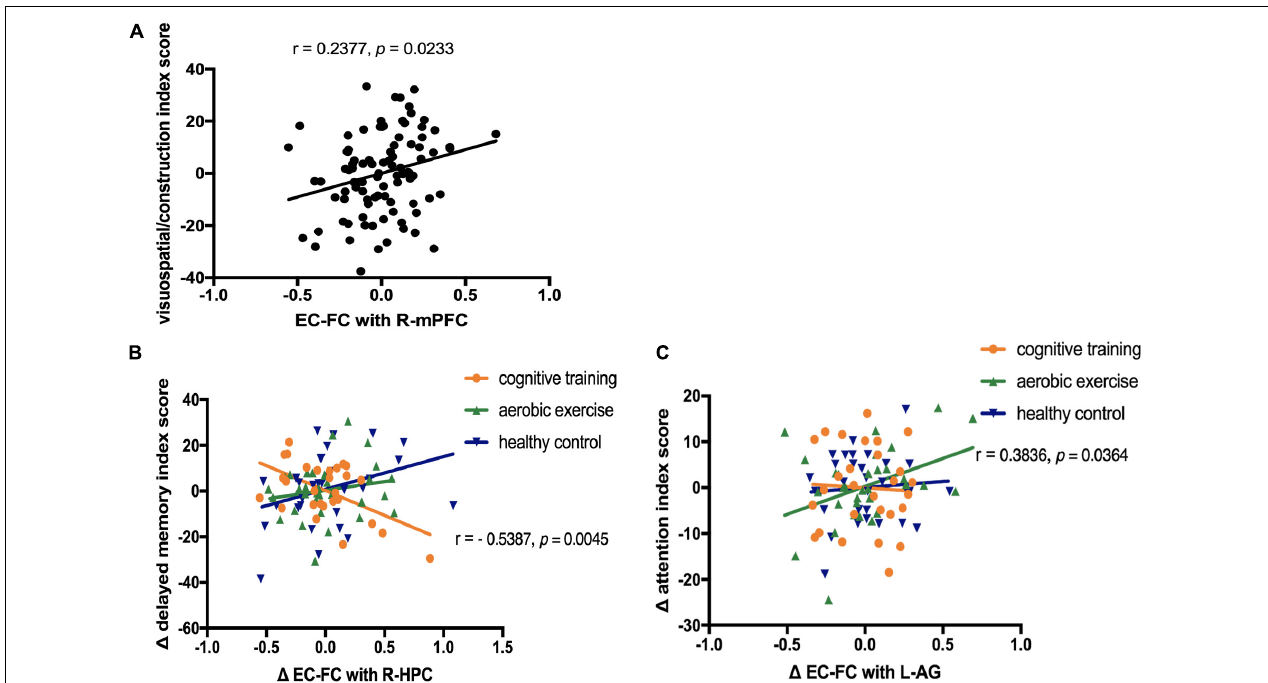
FIGURE 3 | Correlation between the neuropsychological assessments and entorhinal cortex functional connectivity (EC-FC) values. (A) Linear correlation between the EC-FC values with the right medial prefrontal cortex(R-mPFC) and the visuospatial/constructional index score of the Repeatable Battery for the Assessment of Neuropsychological Status (RBANS) at baseline ( r = 0.24, p = 0.02, no correction). (B) Linear correlation between the EC-FC value changes with the right hippocampus (R-HPC) and the change in the RBANS delayed memory index score in the cognitive training group [ r = − 0.54, p = 0.005, corrected for multiple comparisons (FDR, q <0.05)]. (C) Linear correlation between the EC-FC value changes with the left angular gyrus (L-AG) and the change in the RBANS attention index score in the aerobic exercise group ( r = 0.38, p = 0.04, no